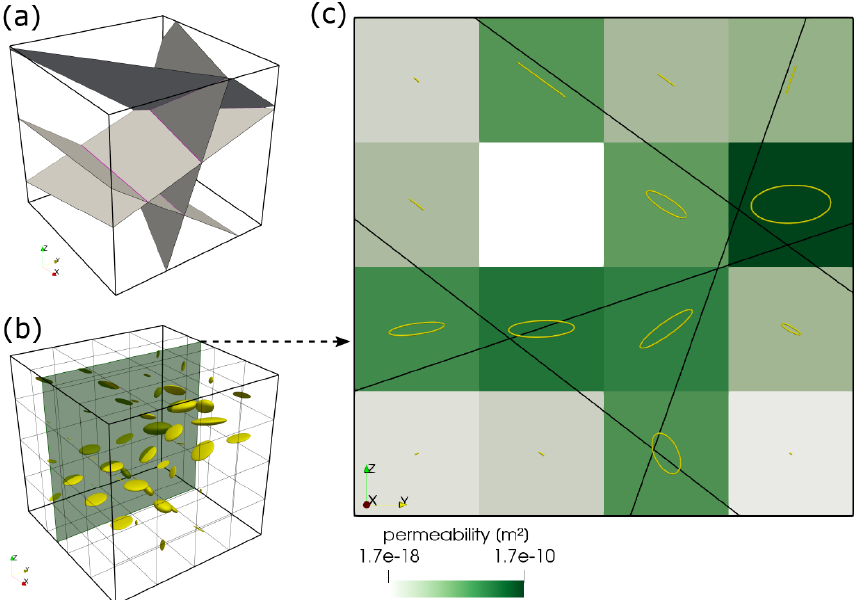
Figure 3. Workflow for generating an equivalent continuum model of a DFN. Panel (a) shows the input fracture network of four arbitrarily oriented fractures (gray) and their intersections (magenta). Panel (b) displays a grid of ellipsoids, each reflecting the shape of the permeability tensor in the equivalent continuum model in (a) with a resolution of 4 3 voxels. The size of the ellipses is scaled to the norm of the permeability tensor of the cell such that larger ellipsoids denote higher permeabilities. The green plane in (b) indicates the location of the 2D slice displayed in (c) . Different green intensities present the norm of the permeability tensor of each cell. Black lines denote fractures in 2D and yellow ellipses the x and y shape of the permeability tensor of each cell. Note how the shape of the ellipse changes from being planar if multiple fractures cross a